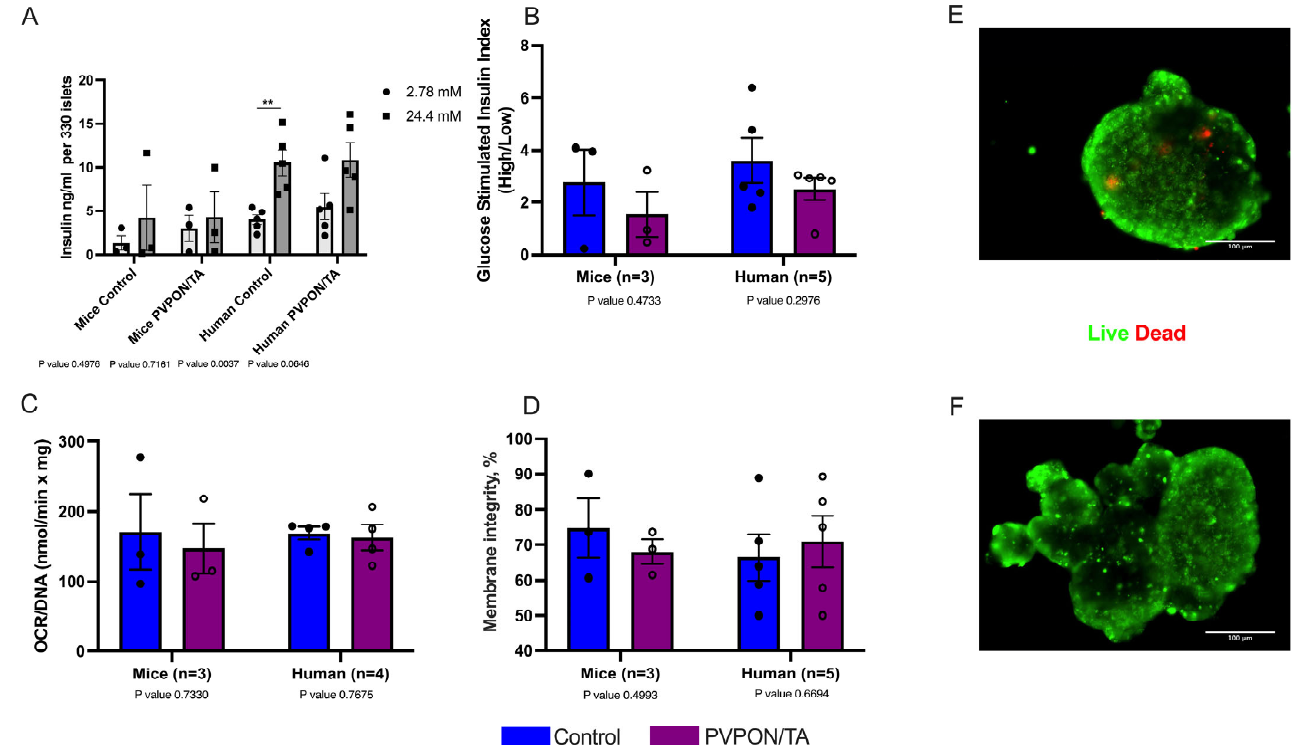
Figure 3. In vitro function evaluations of non-coated (control-blue) and PVPON/TA-coated (purple) mouse and human islets. Glucose stimulated insulin levels (GSIS) (** p < 0.01, two-tailed t -test) ( A ) and stimulation index ( B ) from non-coated and coated mouse ( n = 3 isolations) and human islets ( n = 5 human donors). Oxygen consumption rates (OCR/DNA) of non-coated and PVPON/TA-coated mouse and human islets ( C ). Comparison of vitality measured by membrane integrity of non-coated and PVPON/TA-coated mouse and human islets ( D ). Representative live (green) and dead (red) membrane staining of non-coated ( E ) and PVPON/TA-coated ( F ) human islets. Data represented as mean ± SEM. Scale bars represent 100 µm.